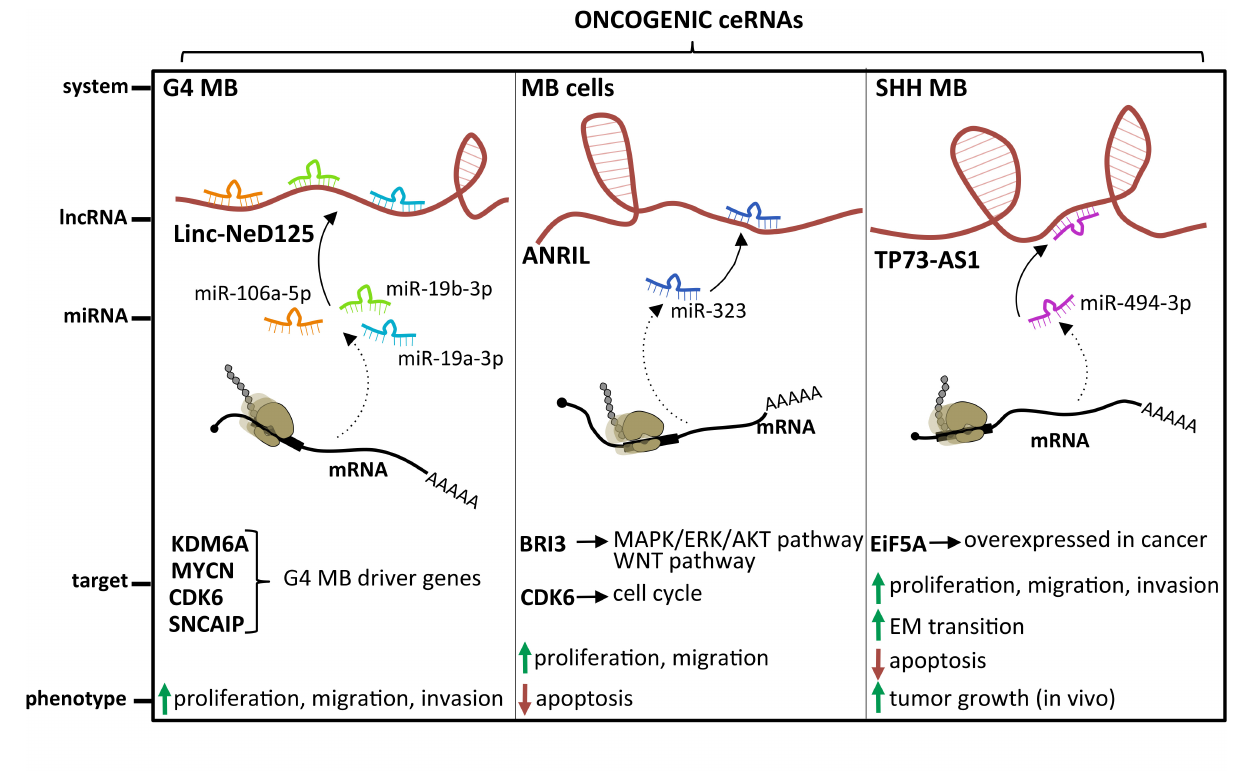
FIGURE 4 | State of the art on lncRNAs functioning as oncogenes or oncosuppressors through their competing endogenous RNA (ceRNA) activity. A handful of lncRNAs, such as Linc-NeD125, ANRIL, TP73-AS1, HOTAIR, and CRNDE, may function as oncogenes by sponging specific miRNAs and leading to derepression of their target genes. Differently, only NKX2-2AS has been described as a lncRNA endowed with oncosuppressor activity.